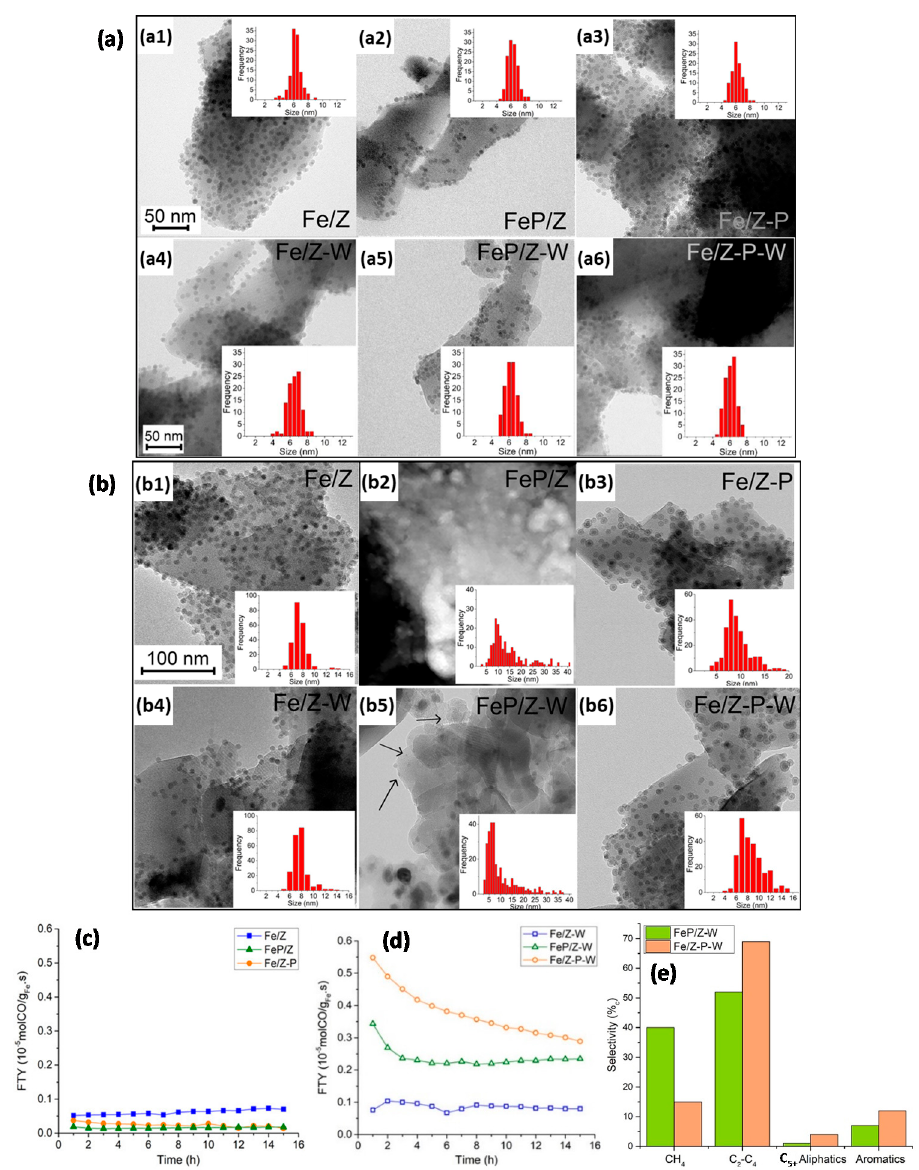
Figure 5. ( a ) TEM of as-prepared ( a1 ) Fe/Z, ( a2 ) FeP/Z, ( a3 ) Fe/Z-P, ( a4 ) Fe/Z-W, ( a5 ) FeP/Z-W and ( a6 ) Fe/Z-P-W. ( b ) Post-FTO TEM of ( b1 ) Fe/Z, ( b2 ) FeP/Z, ( b3 ) Fe/Z-P, ( b4 ) Fe/Z-W, ( b5 ) FeP/Z-W and ( b6 ) Fe/Z-P-W. Insets in ( a ) and ( b ) denote Fe NP size distributions. ( c ) Iron time yields (FTY, defined as moles of CO being converted per gram of iron per second) as a function of time-on-stream (TOS) for as-prepared, unwashed catalysts and ( d ) washed catalysts. Reaction conditions: T = 340 °C, P = 1 bar, H 2 /CO = 1/1 ( V / V ), CO conversion ~3–5%, GHSV = 5000 h − 1 . ( e ) Product selectivities of FeP/Z-W and Fe/Z-P-W in FTO conditions (T = 340 °C, P = 1 bar, H 2 /CO = 1 ( V / V ), GHSV: 4 200 h − 1 , TOS = 15 h). Adapted with permission from Ref. [97], https://pubs.acs.org/doi/abs/10.1021/acscatal.9b04380.